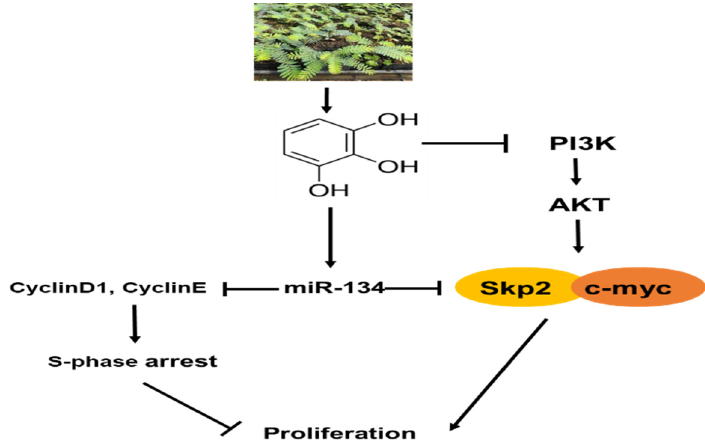
Figure 7. Molecular mechanisms of Pyrogallol via miR-134 activation mediated S-phase arrest and inhibition of the P13K/AKT/SKP2 and cMyc signaling axis.